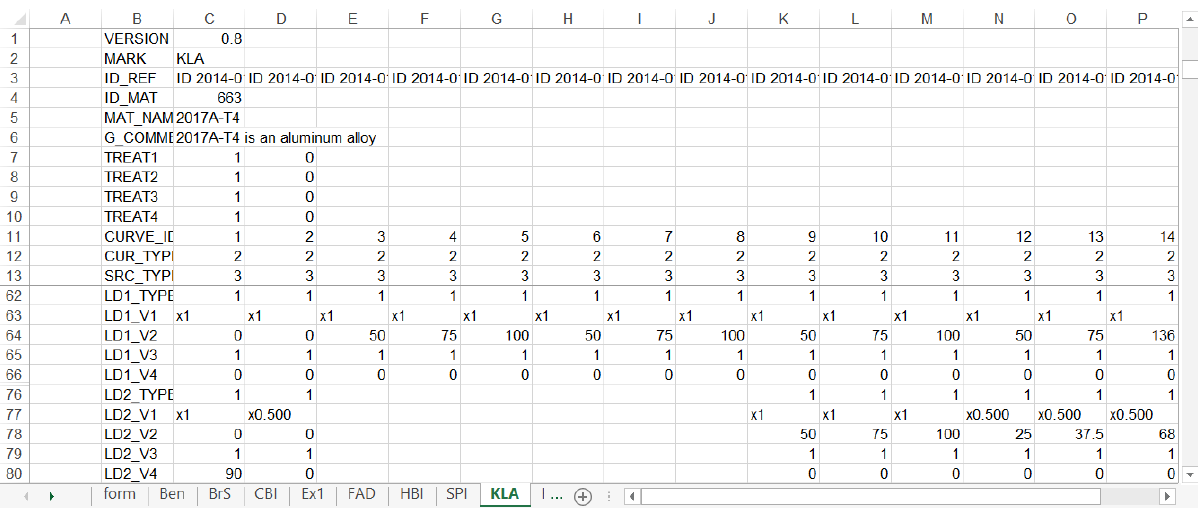
Figure 2. A datasheet of FinLiv with sample